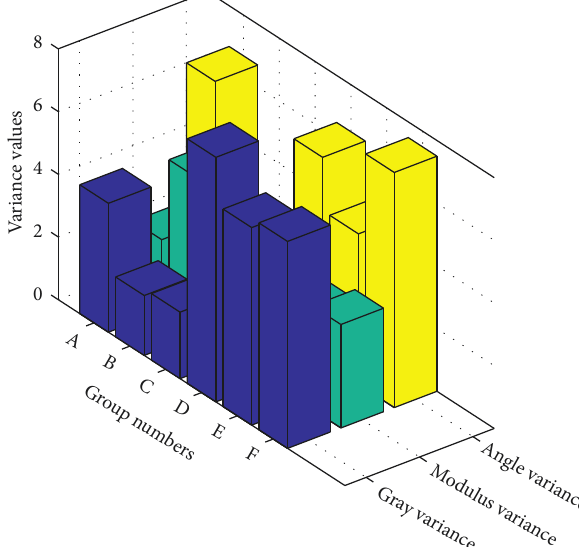
Figure 6: Variance distribution of image sequence in different experimental